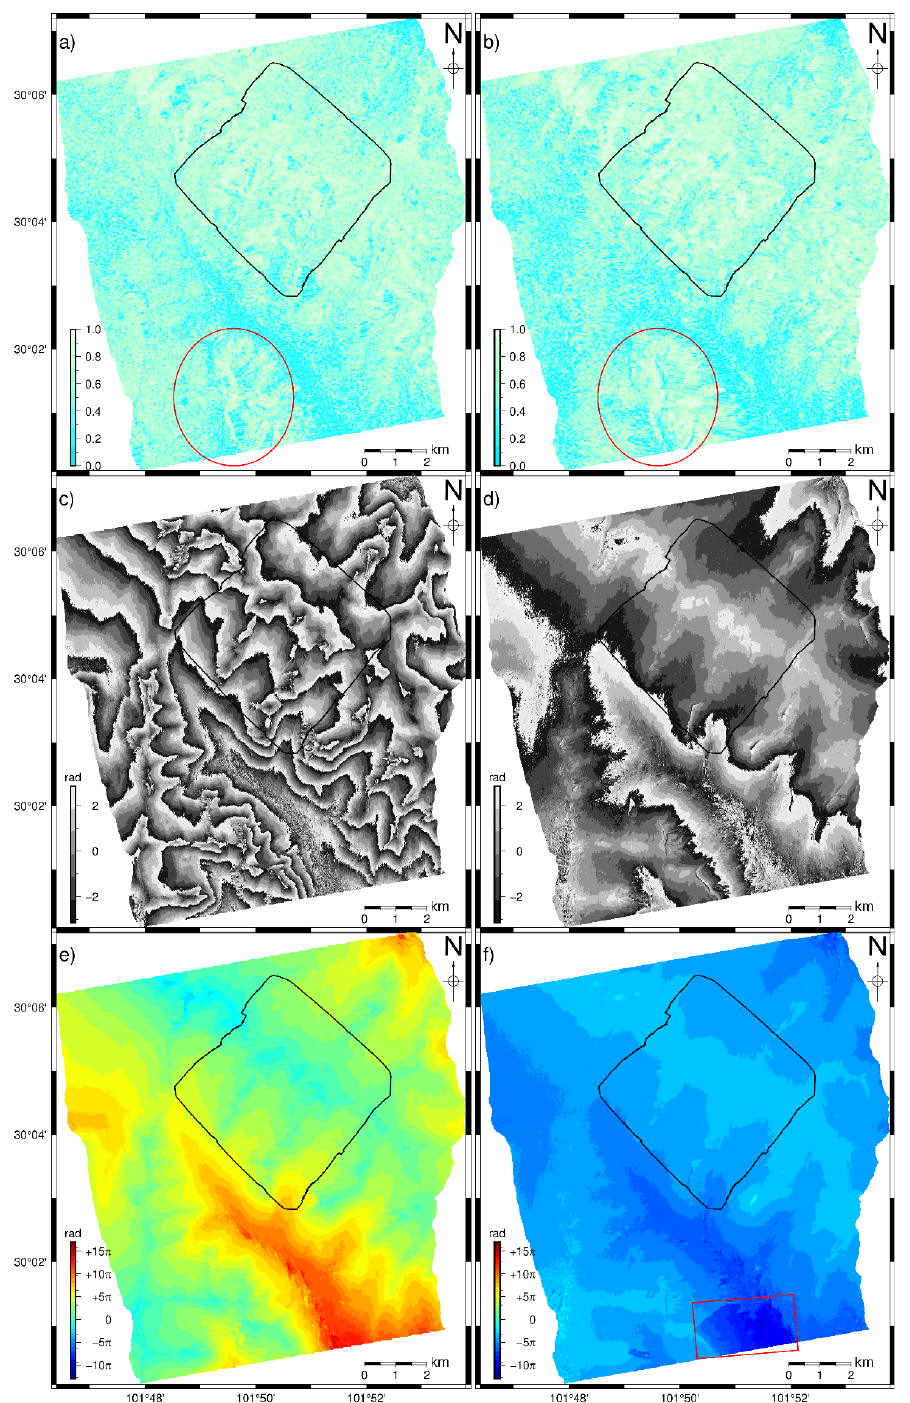
Figure 9. Related products during the InSAR processing: ( a ), ( c ), ( e ) and ( b ), ( d ), ( f ) are the coherence, interferogram, and unwrapped phase data of the ascending and descending data, respectively. The temporal baseline of both the ascending and descending data is 12 days, and the perpendicular baseline is 84.54 and 31.87 m, respectively. The black polygon is the area surveyed by the UAV, the red circle indicates the points with large differences in coherence, and the red rectangle shows the area with anomalies.